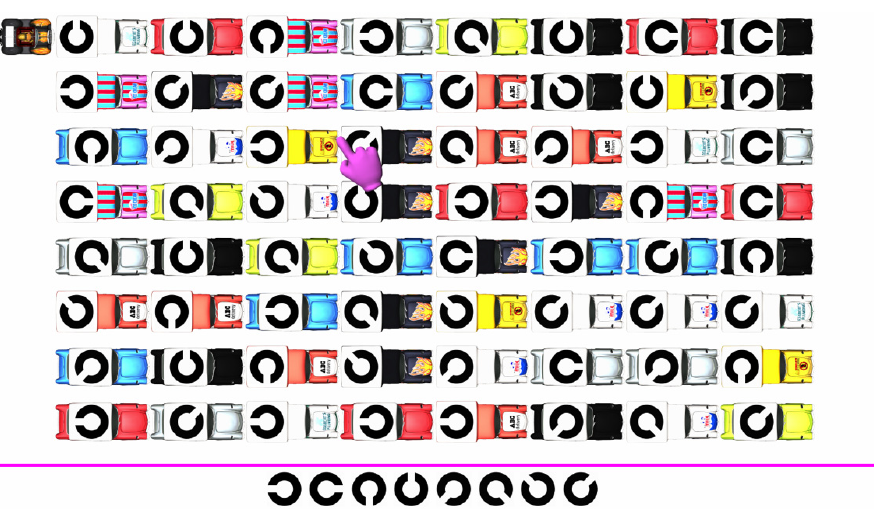
Figure 2. Game called “Traffic jam” based on orientation discrimination with Landolt C optotypes.